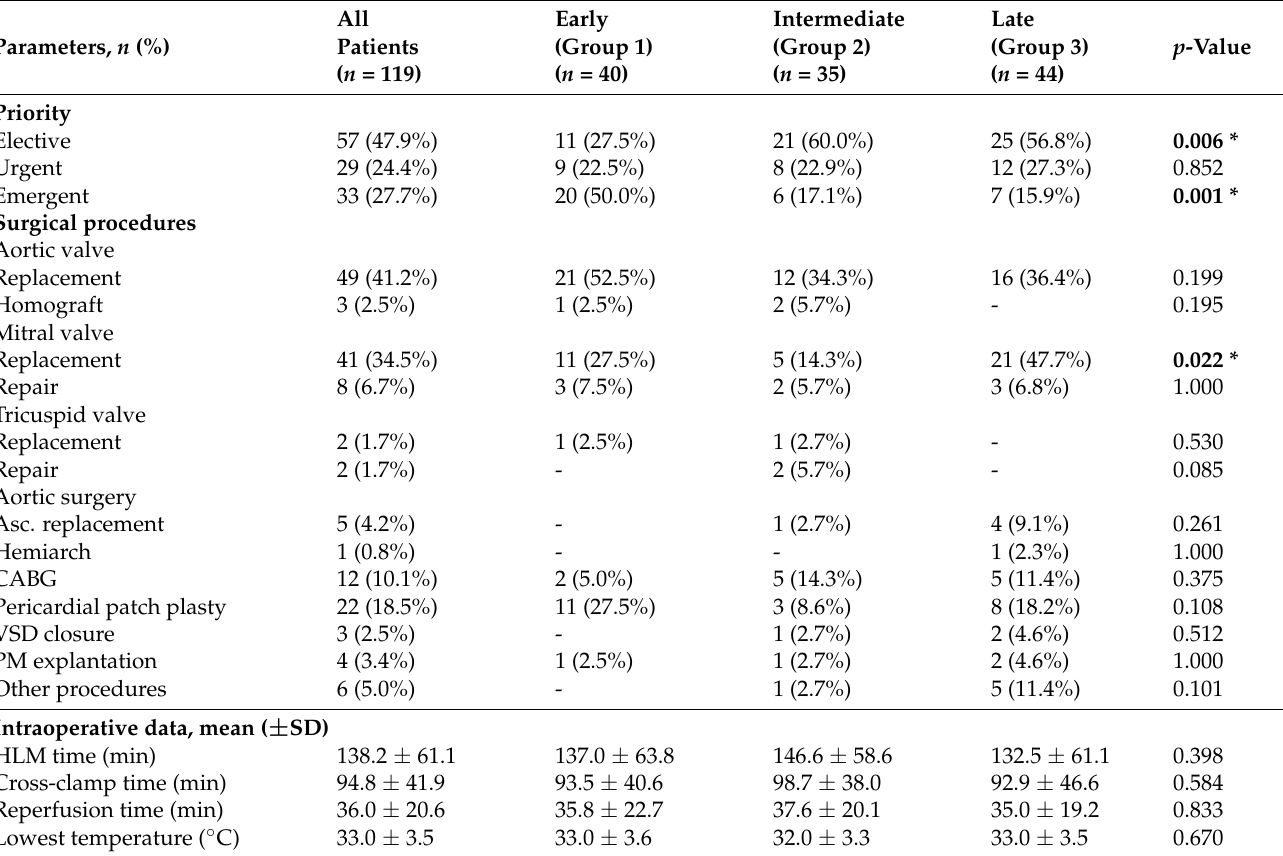
Table 3. Intraoperative data ( n = 119).